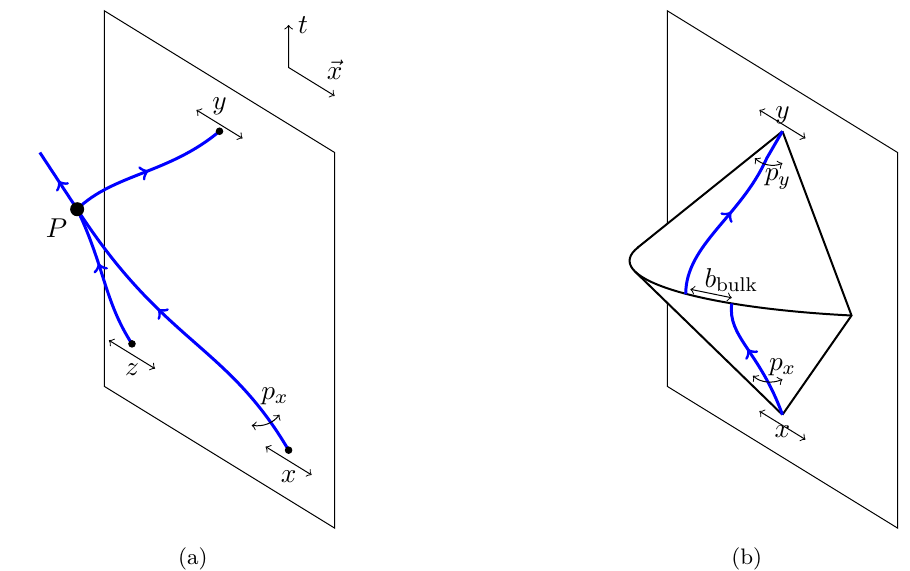
Figure 1 . Two models of holographic cameras. In both, an energetic projectile is fired from a boundary point x µ with initial momentum p µ . The plane represents the R 1 ,d − 1 boundary spacetime x in which we can do measurements, and the thick blue paths are null geodesics in the (arbitrary) bulk metric. (a) In the radar camera (1.3), one sends a pulse from a point z and records at y its reflection off the projectile. (b) In the active camera (1.4), one records how the projectile interferes with the reverse time evolution of a second one reaching y with momentum p y . In a theory with local bulk dynamics, this signal will be sharply peaked around vanishing bulk impact parameter b bulk